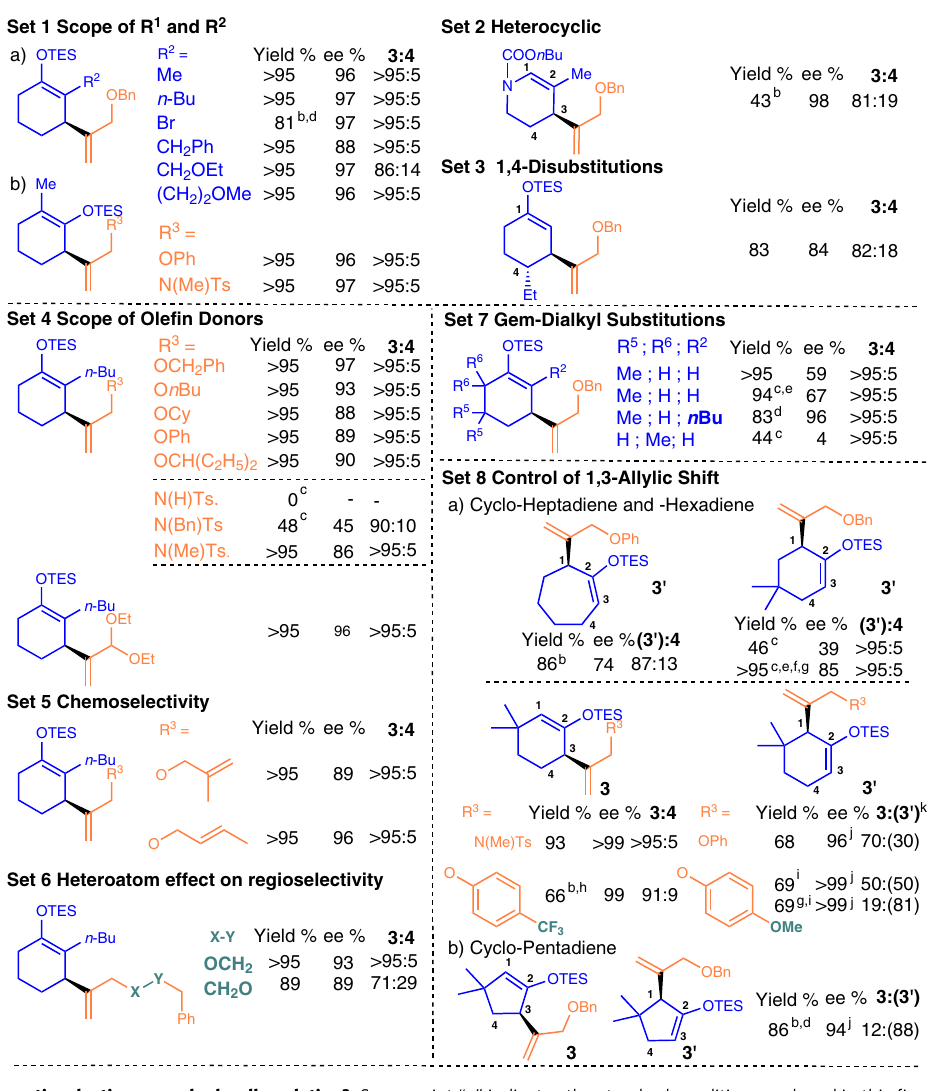
Fig. 3 Scope of the enantioselective cross-hydroalkenylation a . Superscript “ a ” indicates the standard condition employed in this fi gure: [ L3 -Ni(allyl)]BAr F catalyst (5 mol%, 0.05 mmol), cyclic 1,3-diene 1 : heterosubstituted terminal ole fi n 2 = 1:3, in 4 mL of toluene at r.t. for 6 h. Yield, chiral 1,4-diene 3 : 4 or 3 : 3 ’ or 3 ’ : 4 ratio were determined by 1 H NMR spectroscopy, except otherwise indicated. No chiral 1,4-diene 3 ’ was observed, except in Set 8. Major regioisomer ’ s structure was con fi rmed by isolation and enantiomeric excesses were determined by HPLC. Superscript “ b and c ” indicate the amount of catalyst employed, which is 10 mol% and 20 mol%, respectively. Superscript “ d ” indicates an extra 1 equiv. of heterosubstituted terminal ole fi n 2 was added after 2 h. Superscript “ e ” indicates L1 was used instead of L3 . Superscript “ f ” indicates that heterosubstituted terminal ole fi n 2 was added in three equal portions in 6 h. Superscript “ g ” indicates taht the reaction was carried out at 0 °C. Superscript “ h ” indicates the ratio of cyclic 1,3-diene 1 to heterosubstituted terminal ole fi n 2 here was 1:1.5, and reaction time was 11 h. Superscript “ i ” indicates that reaction time was 15 h. Superscript “ j ” indicates the ee value of chiral 1,4-diene 3 ’ . Superscript “ k ” indicates that 4 was also observed in those entries and in 27, 17, and 8% yield,